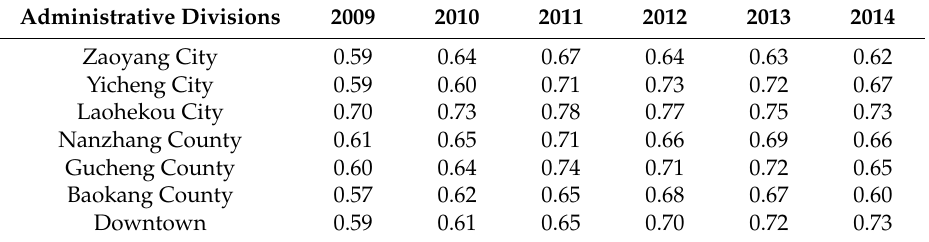
Table 5. Overall harmonious development degree of socio-economy and RLS in Xiangyang City. Administrative Divisions